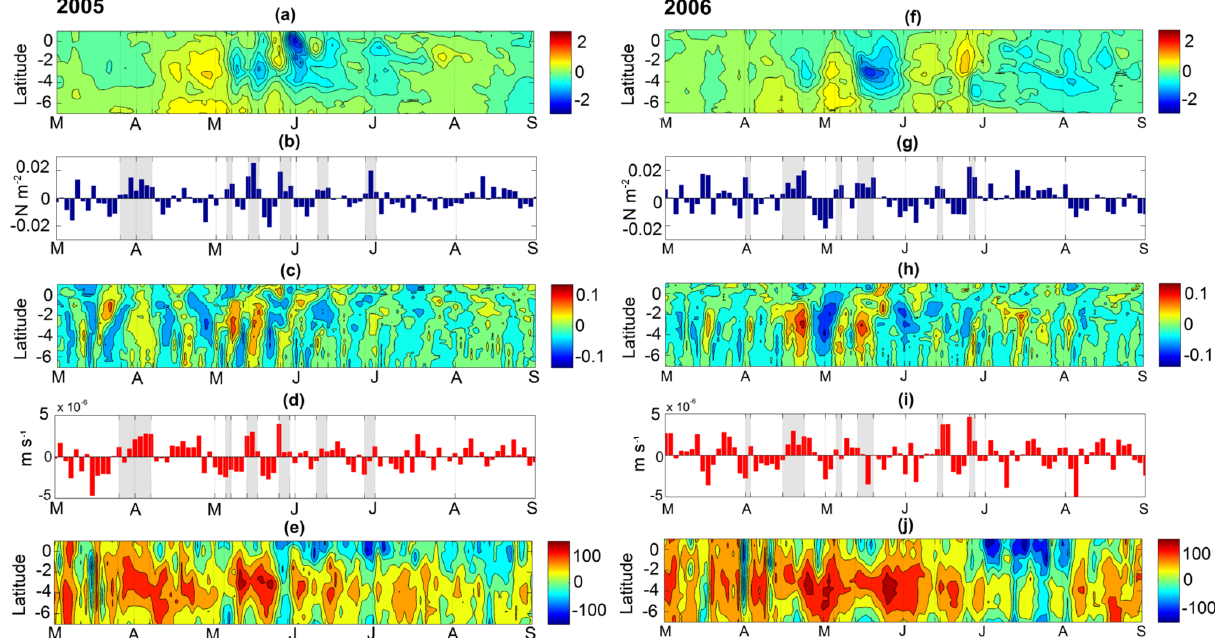
Figure 4. ( a and f ) Time–latitude diagram from 7 ◦ S to 1 ◦ N of the intraseasonal variations of sea surface temperature (in ◦ C) averaged between 5 and 12 ◦ E; ( b and g ) time evolution of the intraseasonal variations of wind stress amplitude (Nm − 2 ) averaged between 5 and 12 ◦ E and between 3 and 0 ◦ S; ( c and h ) latitude–time diagram of the intraseasonal variations of the maximum of the current vertical shear magnitude (ms − 1 ) averaged between 5 and 12 ◦ E; ( d and i ) longitude–time diagram of the intraseasonal variations of Ekman pumping (ms − 1 ) averaged over the CLR. Ekman pumping values>0 indicate upwelling; ( e and j ) latitude–time diagram of the net heat flux (Wm − 2 ) averaged between 5 and 12 ◦ E from 1 March to 31 August 2005 (left panels) and 2006 (right panels). For details about calculations of intraseasonal variations, see Sect. 2. The intraseasonal southerly wind events are indicated by the shaded areas. Note that the cooling episodes occur a few days after the southerly wind